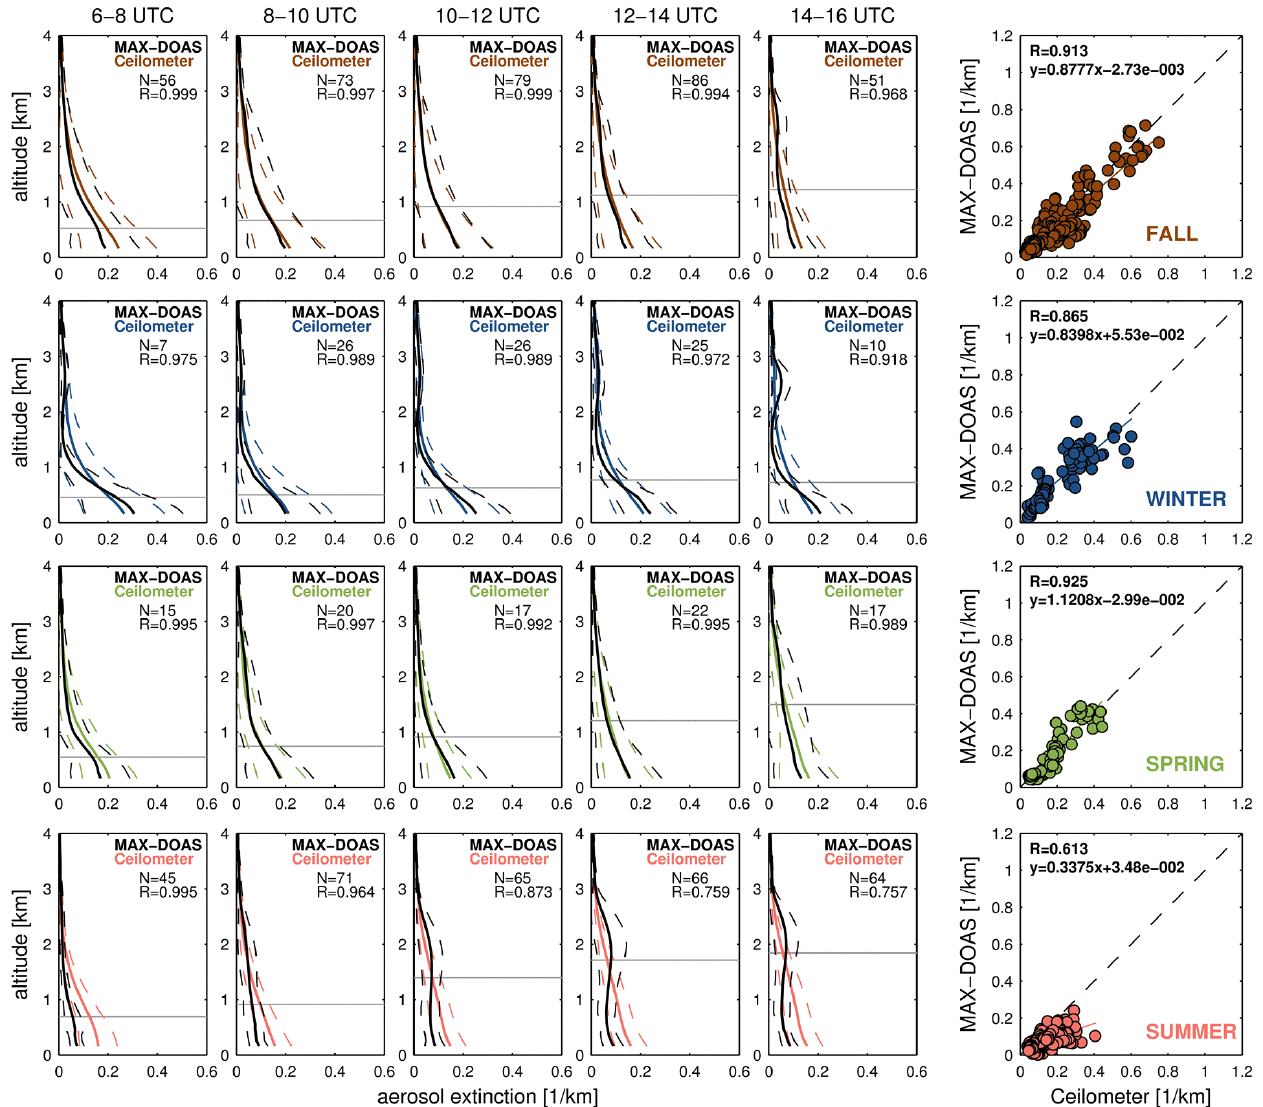
Figure 6. Same as Fig. 5 but for the visible channel (MAX-DOAS: 425–490nm, ceilometer: